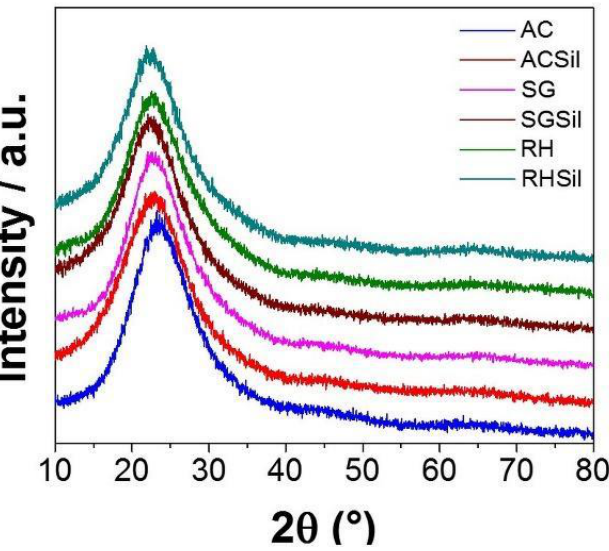
Figure 1. XRD diffractograms for SiO 2 with unmodified surface and modified surface with TMSCl silane.